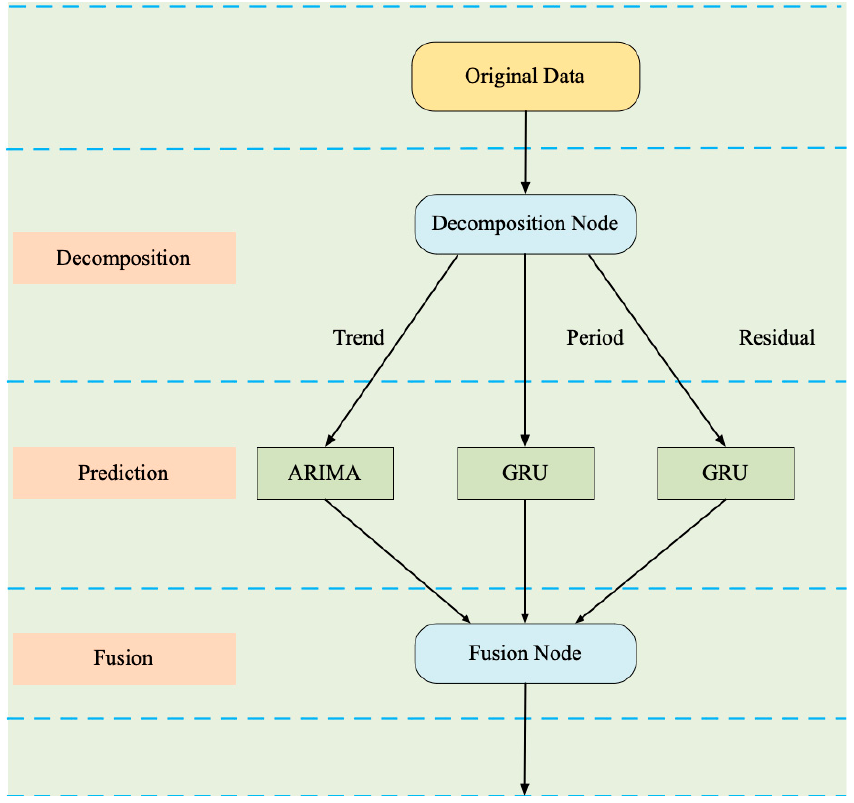
Figure 2. Flowchart of the prediction framework.